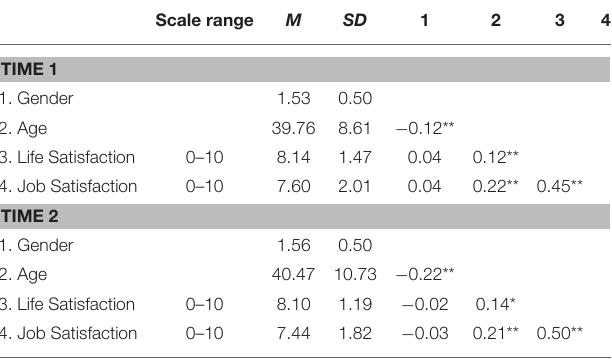
TABLE 1 | Descriptives and inter-correlations between all study 1 variables.